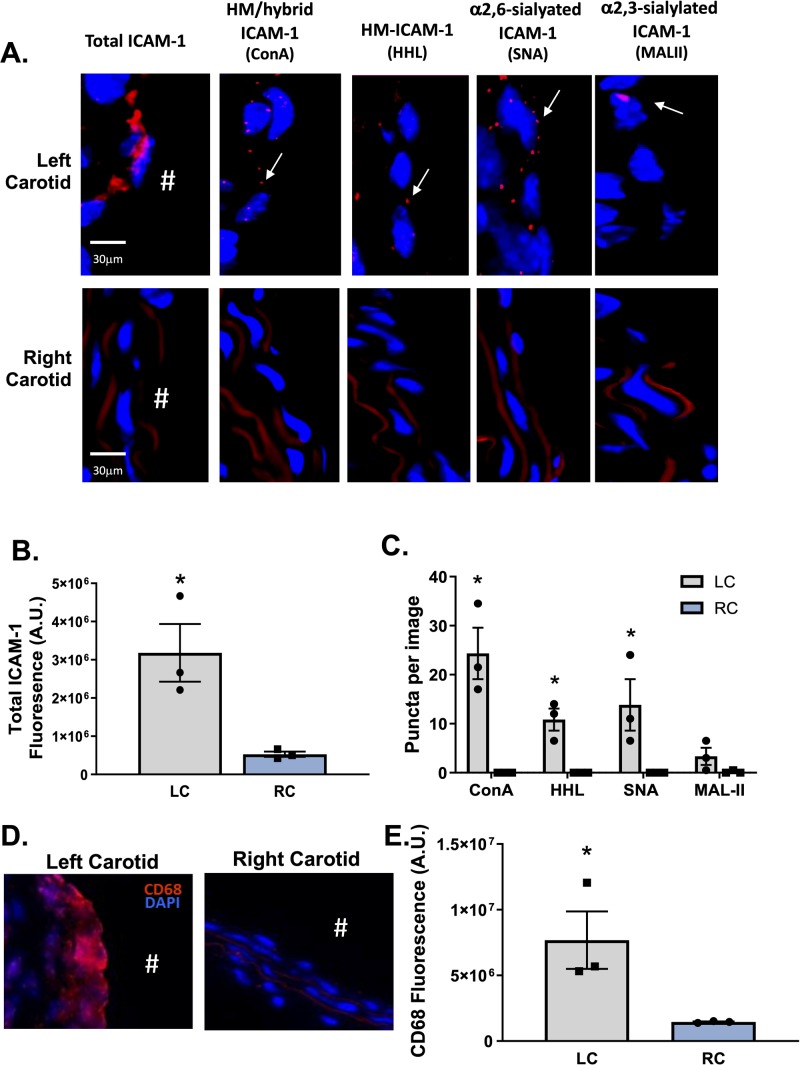
HM / hybrid, HM, and α-2,6-sialylated ICAM-1 are increased in mouse atherosclerosis after induction of disturbed flow in vivo.Panel A shows representative images of total ICAM-1 HM / hybrid, HM, α2,6-sialylated, and α2,3-sialylated ICAM-1 in the left carotid artery (after partial ligation) and paired right carotid artery (control). Positive PLA puncta are indicated by arrows. Panels B & C show total ICAM-1 staining in left versus right carotid artery and ICAM-1 N-glycoforms puncta, respectively. Data are mean ± SEM, each symbol represents an individual mouse, n = 3. *p<0.05 compared to RC via paired t-test. D. Representative images of CD68 staining (red) in LC vs. RC areas in mice. E. Quantitation of CD68 staining in LC and RC areas. Data are mean ± SEM, n = 3. *p<0.05 compared to RC via t-test. # indicates the lumen of each vessel.